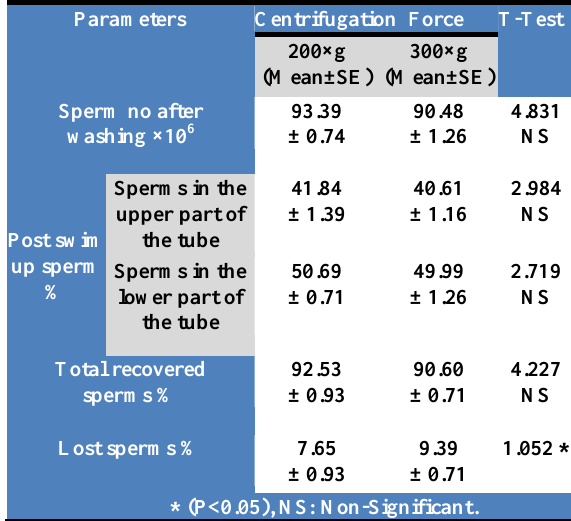
Table, 1: Number of local buck sperms (×10 6